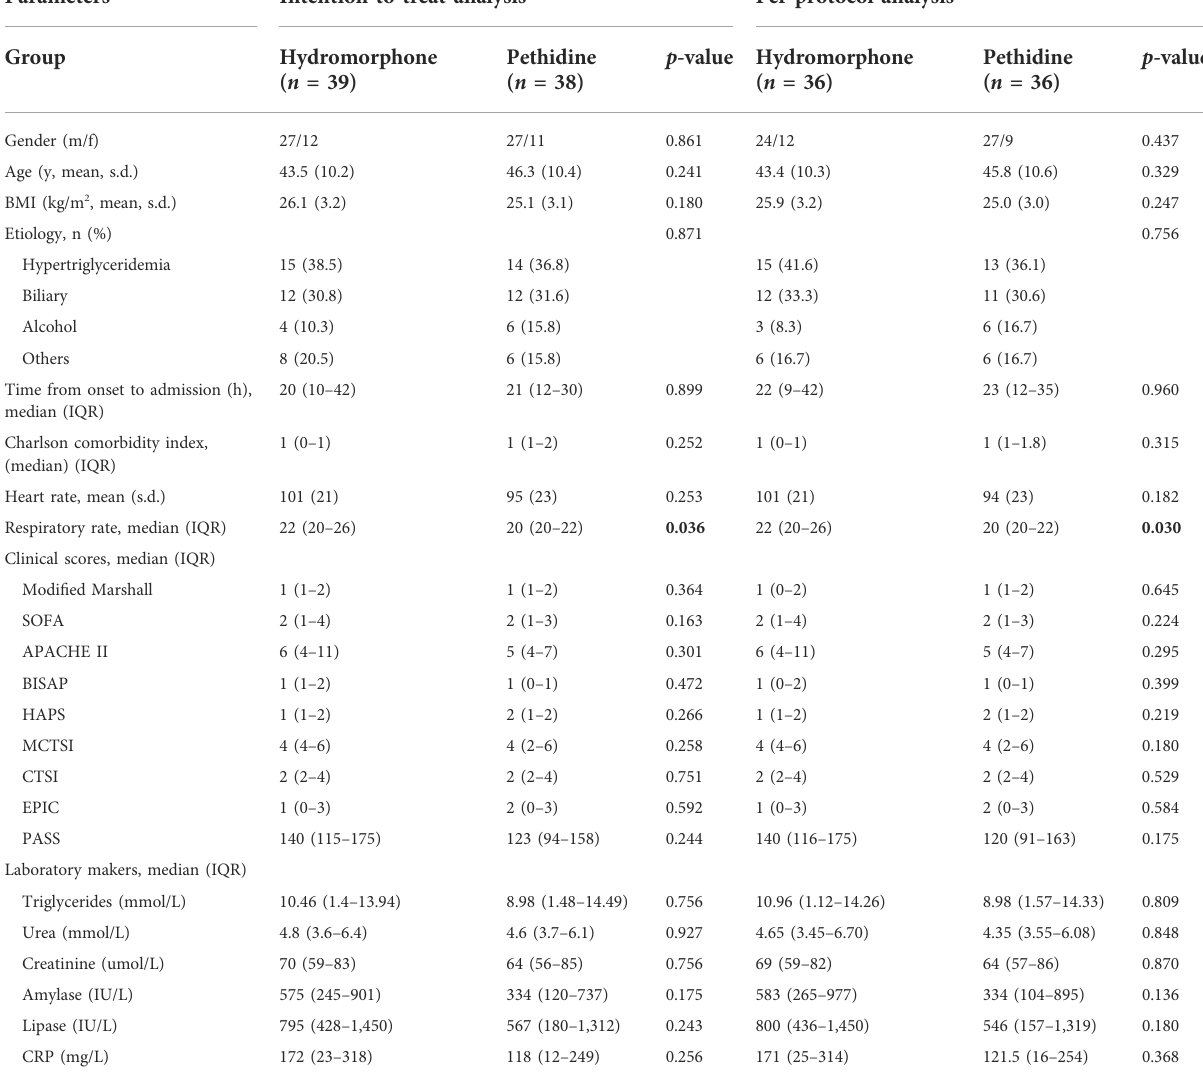
TABLE 1 Baseline characteristics of patients based on intention-to-treat and per-protocol